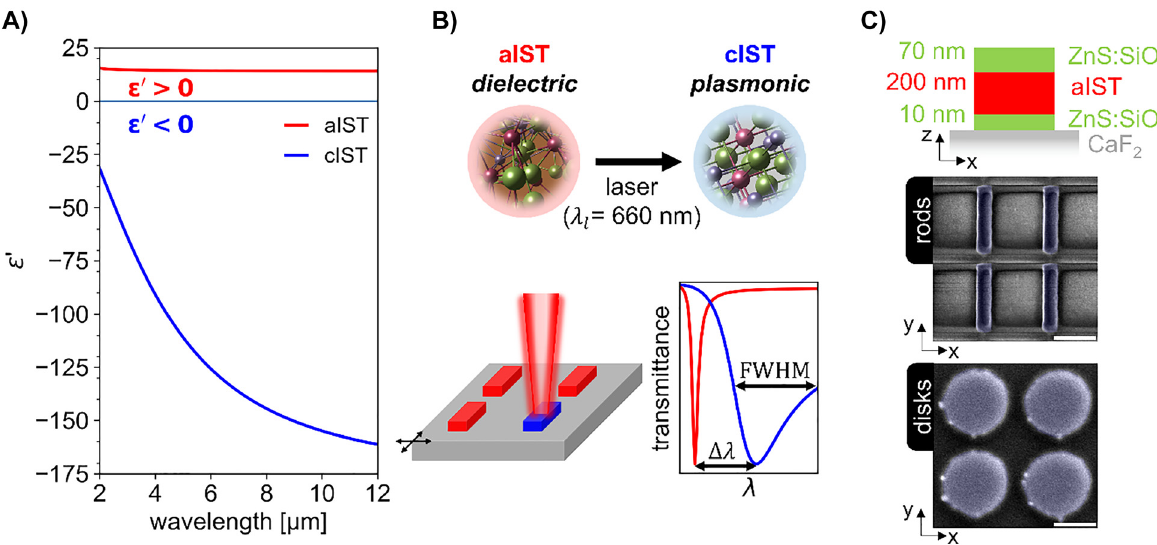
Figure 1: Optically switching nanostructured In 3 SbTe 2 (IST) antennas between dielectric and plasmonic response. (A) The real part of the permittivity, ε ′ , of IST changes its sign from positive in the amorphous phase (aIST, red) to negative in the crystalline phase (cIST, blue). (B) A pulsed laser can crystallize the IST and change its infrared optical properties from dielectric ( ε ′ > 0) to plasmonic ( ε ′ < 0). Nanostructured IST-antennas can then be switched between dielectric (aIST, red) and metallic (cIST, blue). This changes the type of the infrared resonances from sharp Mie resonances (aIST) to broad plasmonic resonances (cIST), signi fi cantly tuning both the shift Δ λ and the width FWHM of the resonance. (C)Sketchof thelayerstackofthe investigatedsamples.SEMimages ofnanostructuredISTrodanddiskantennasfabricatedwith focused ion beam milling. The rods and disks are marked with blue-colored transparent overlays as guide-to-the-eye. The scale bars equal 1 µm. Depending on the geometry of the antennas and arrays, either both Δ λ and FWHM (rods) or just FWHM (disks) can be